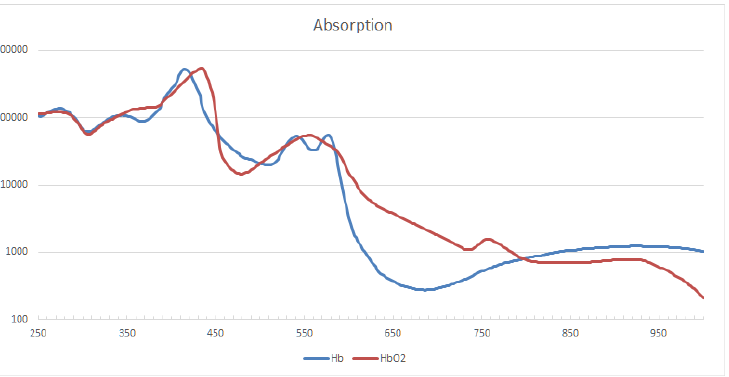
] of Hb and HbO 2 for wavelengths between 250 and mol · cm